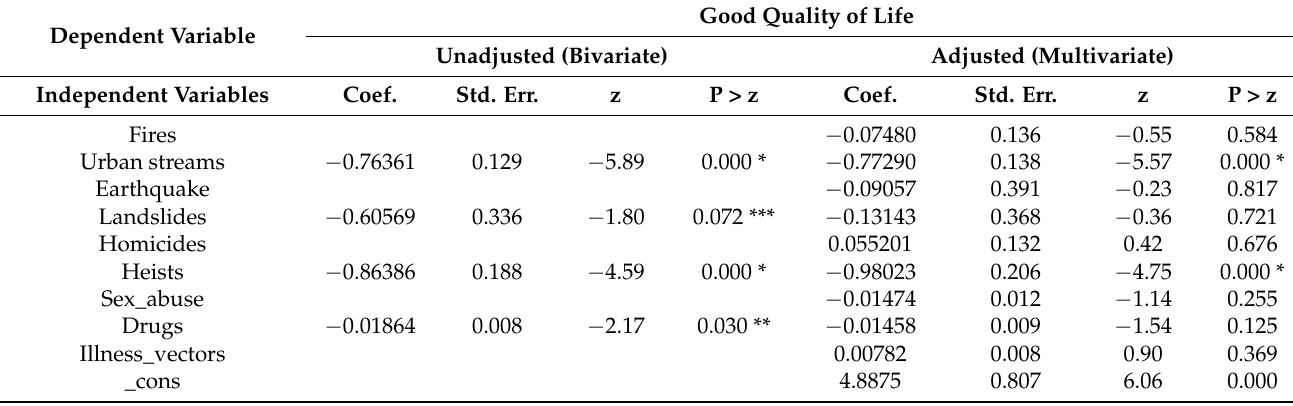
Table 4. Factors influencing respondent’s perceptions of good quality of